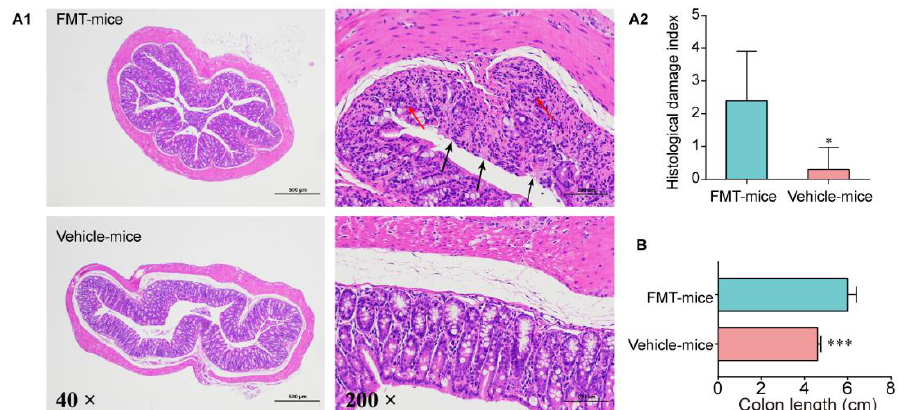
Figure 5. Inflammatory conditions of the colon after FMT. ( A1 ) Representative images of the colon by H&E staining (40× and 200×). The red arrow indicates morphological changes of mucous layer, and the black arrow indicates edema status in submucosa. ( A2 ) Score of inflammation-associated histological changes in the colon. ( B ) Colon length after FMT, n = 5. Data are means ± SD and analyzed by Student’s t-test. * p < 0.05, *** p < 0.0001.